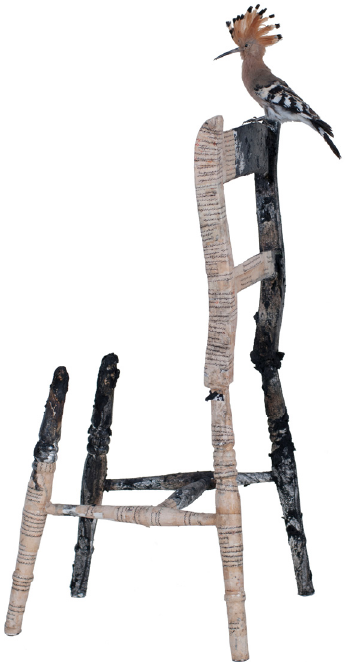
Figure 10. Hanaa Malallah, Chair, 2011. Mixed media with hoopoe bird. © Hanaa Malallah. Inspired by the biblical symbol of the dove, which Pablo Picasso transformed into the iconic symbol of peace bearing an olive branch (La Colombe de la Paix, 1949), she has replaced the dove with the hoopoe and depicts the hoopoe with an olive branch as a metaphor for the struggle for survival (see the “Survival Hoopoe”. Digital Print. 40 × 31 cm; Caravan 2014).